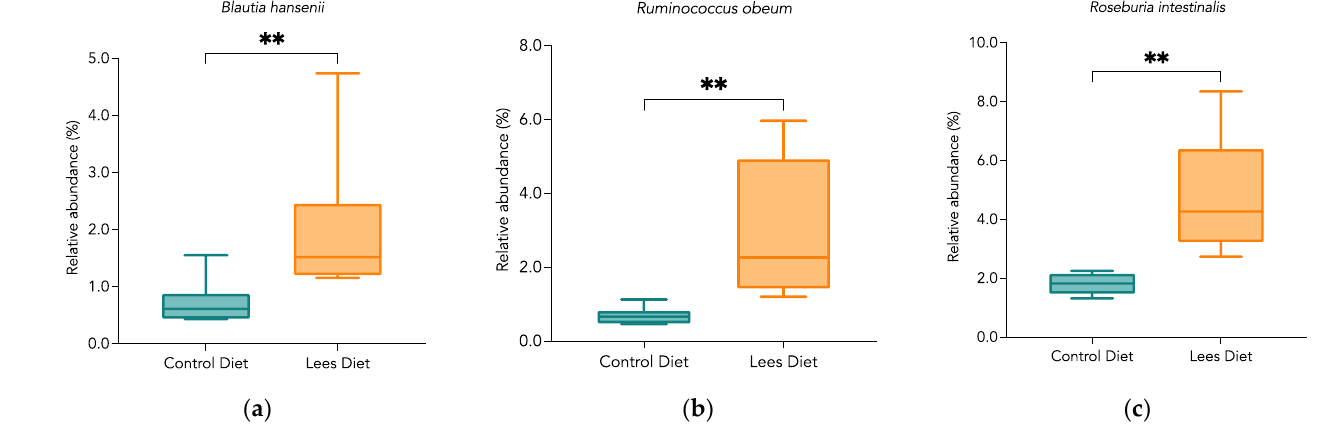
Figure 2. Differences in relative abundance (%) of potentially probiotic bacteria between animals with control and lees diet. Significant differences between groups are indicated with asterisks (*): ( a ) Blautia hansenii ; ( b ) Ruminococcus obeum ; ( c ) Roseburia intestinalis